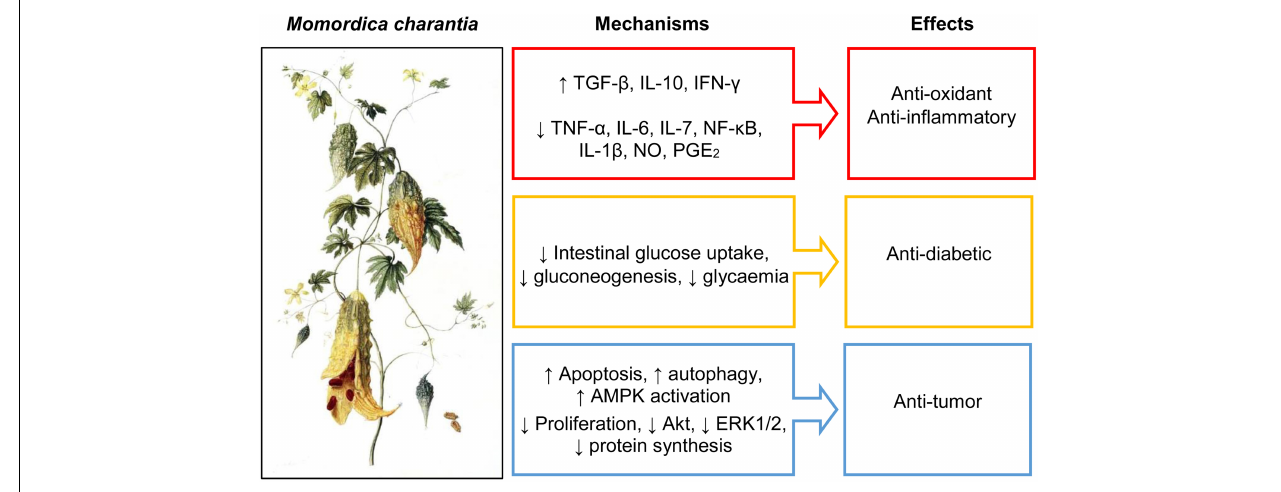
FIGURE 1 | Main mechanisms of Momordica charantia pharmacological